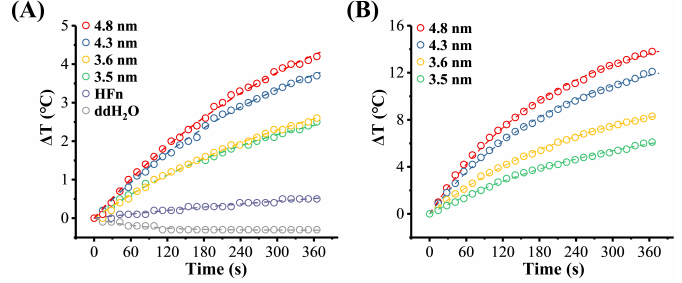
Figure 6. Heating e ffi ciency of MHFn nanoparticles with di ff erent core sizes at ( A ) 1.5 mg[Fe] / mL and ( B ) 5 mg[Fe] / mL. All the measurements were performed in a magnetic field H = 19.5 kA / m and f = 805.5 kHz. Dotted lines are the fitting results of Box-Lucas equation. SLP also increases from 32.7 to 51.3 W / g[Fe] at 1.5 mg[Fe] / mL (Figure 7A and Table 2) and from